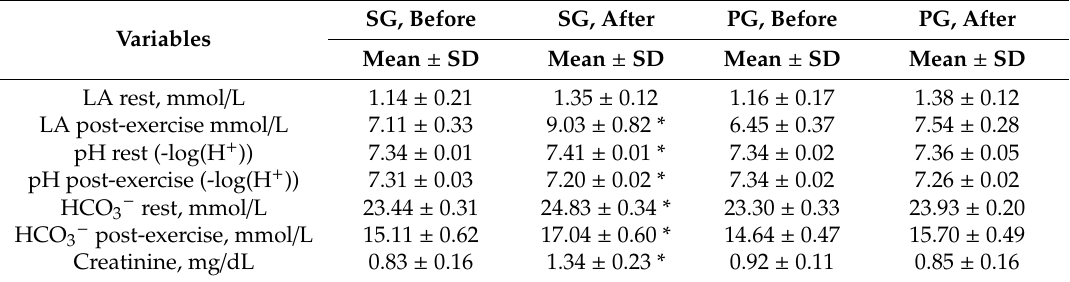
Table 2. Biochemical variables before and after the supplementation